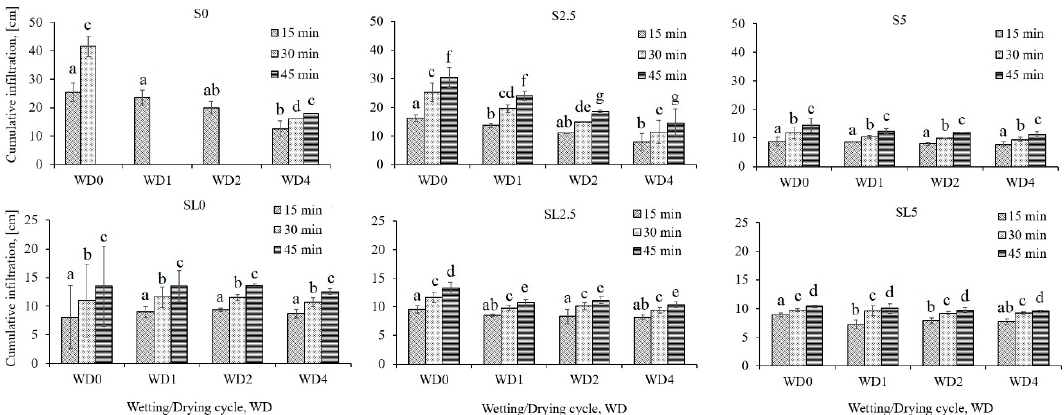
Figure 2. Measured cumulative infiltration ( Icum ) at 15, 30, and 45 min during the wetting and drying cycles WD0, WD1, WD2, and WD4 for the sandy (S) and the sandy loam (SL) treatments. Same letters in the same time period at different WD cycles are significantly similar ( p < 0.05). Error bars denote standard deviation from the mean (N = 3).